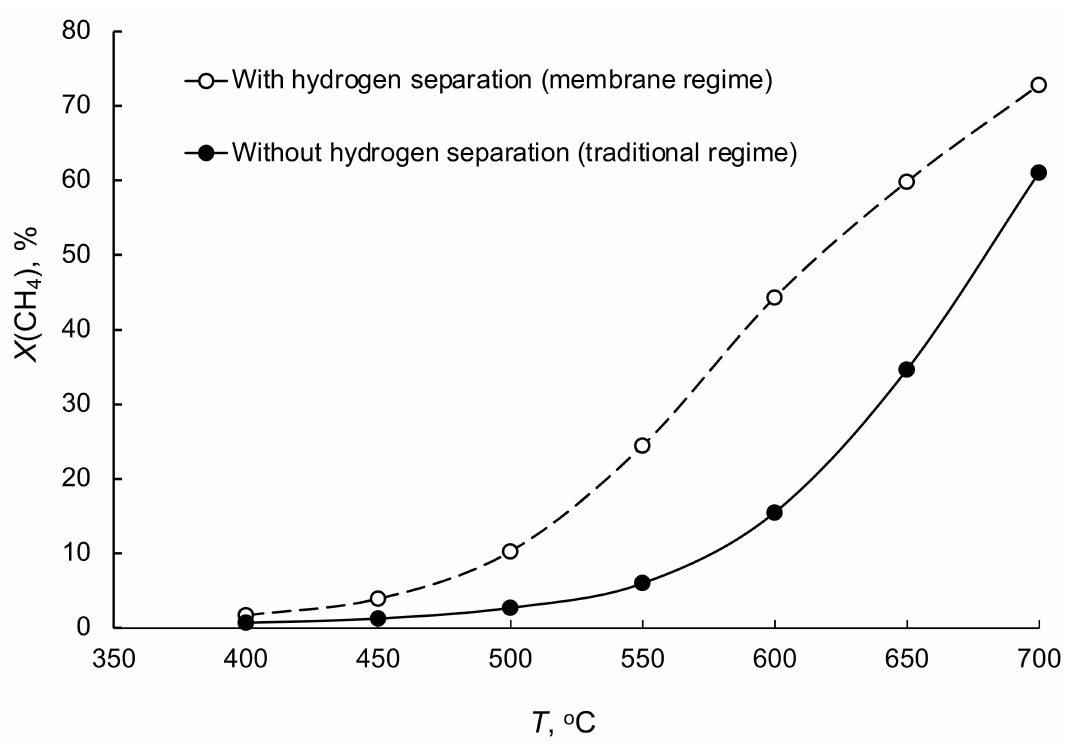
Figure 6. Comparison of the temperature dependences of carbon dioxide reforming of methane accompanied by ultrapure hydrogen extraction from the reaction zone (membrane process) and without extraction (traditional process).